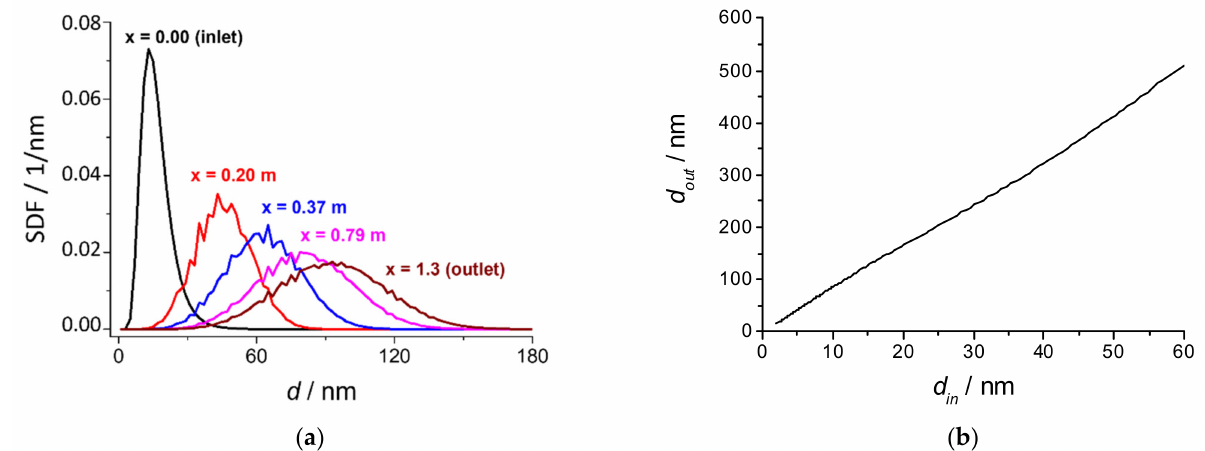
Figure 10. ( a ) Temporal evolution of the soot-particle SDF along the exhaust system of a diesel engine and ( b ) the dependence of the mean diameter of soot particles in the outlet section of the exhaust system on the mean particle diameter in the inlet section.